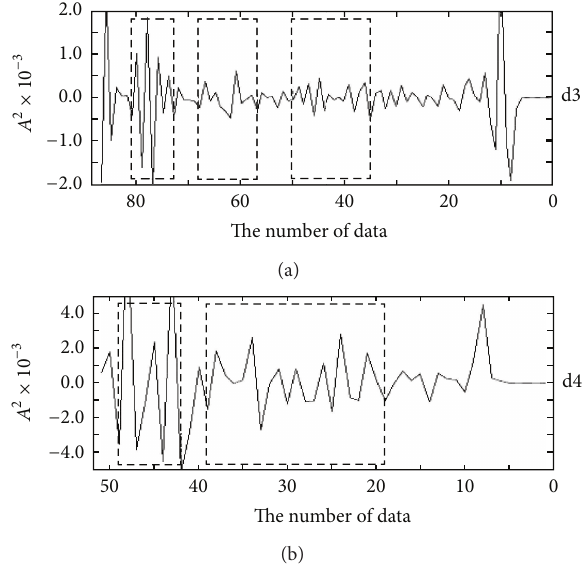
Figure 6: Division of feature region in the DWT domain.